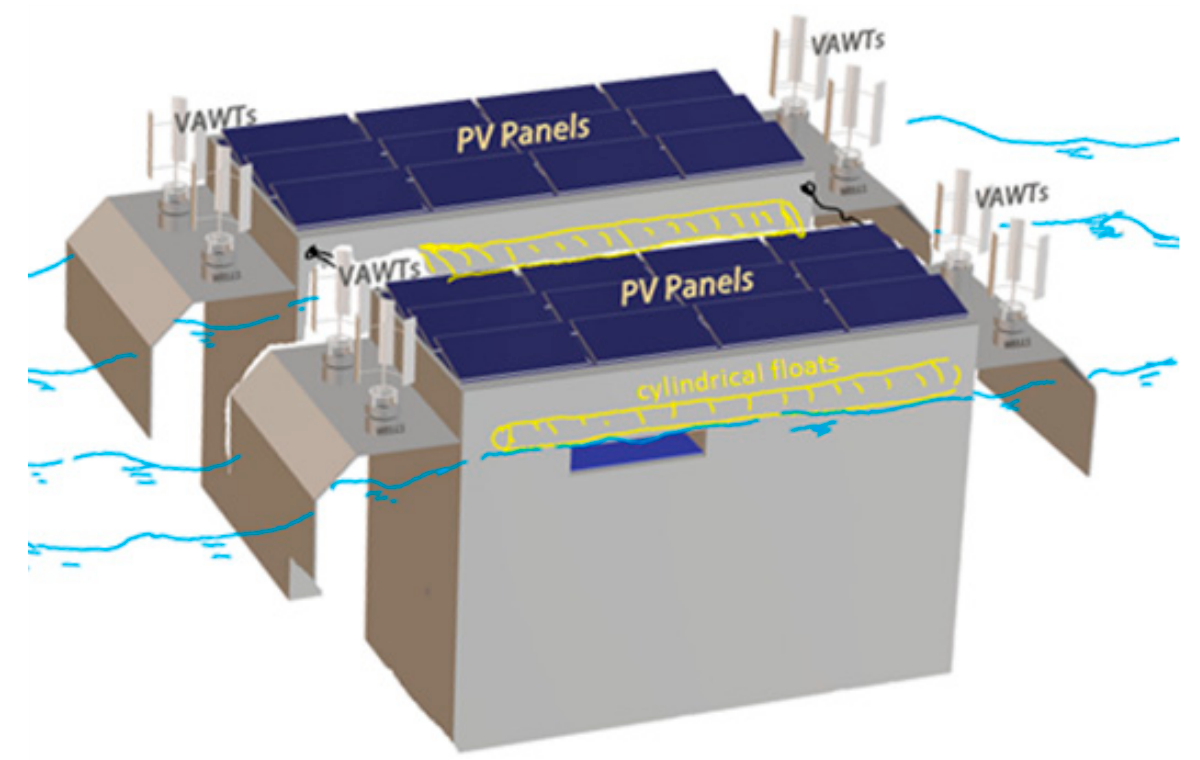
Figure 25. Visualization of the connection between modules.